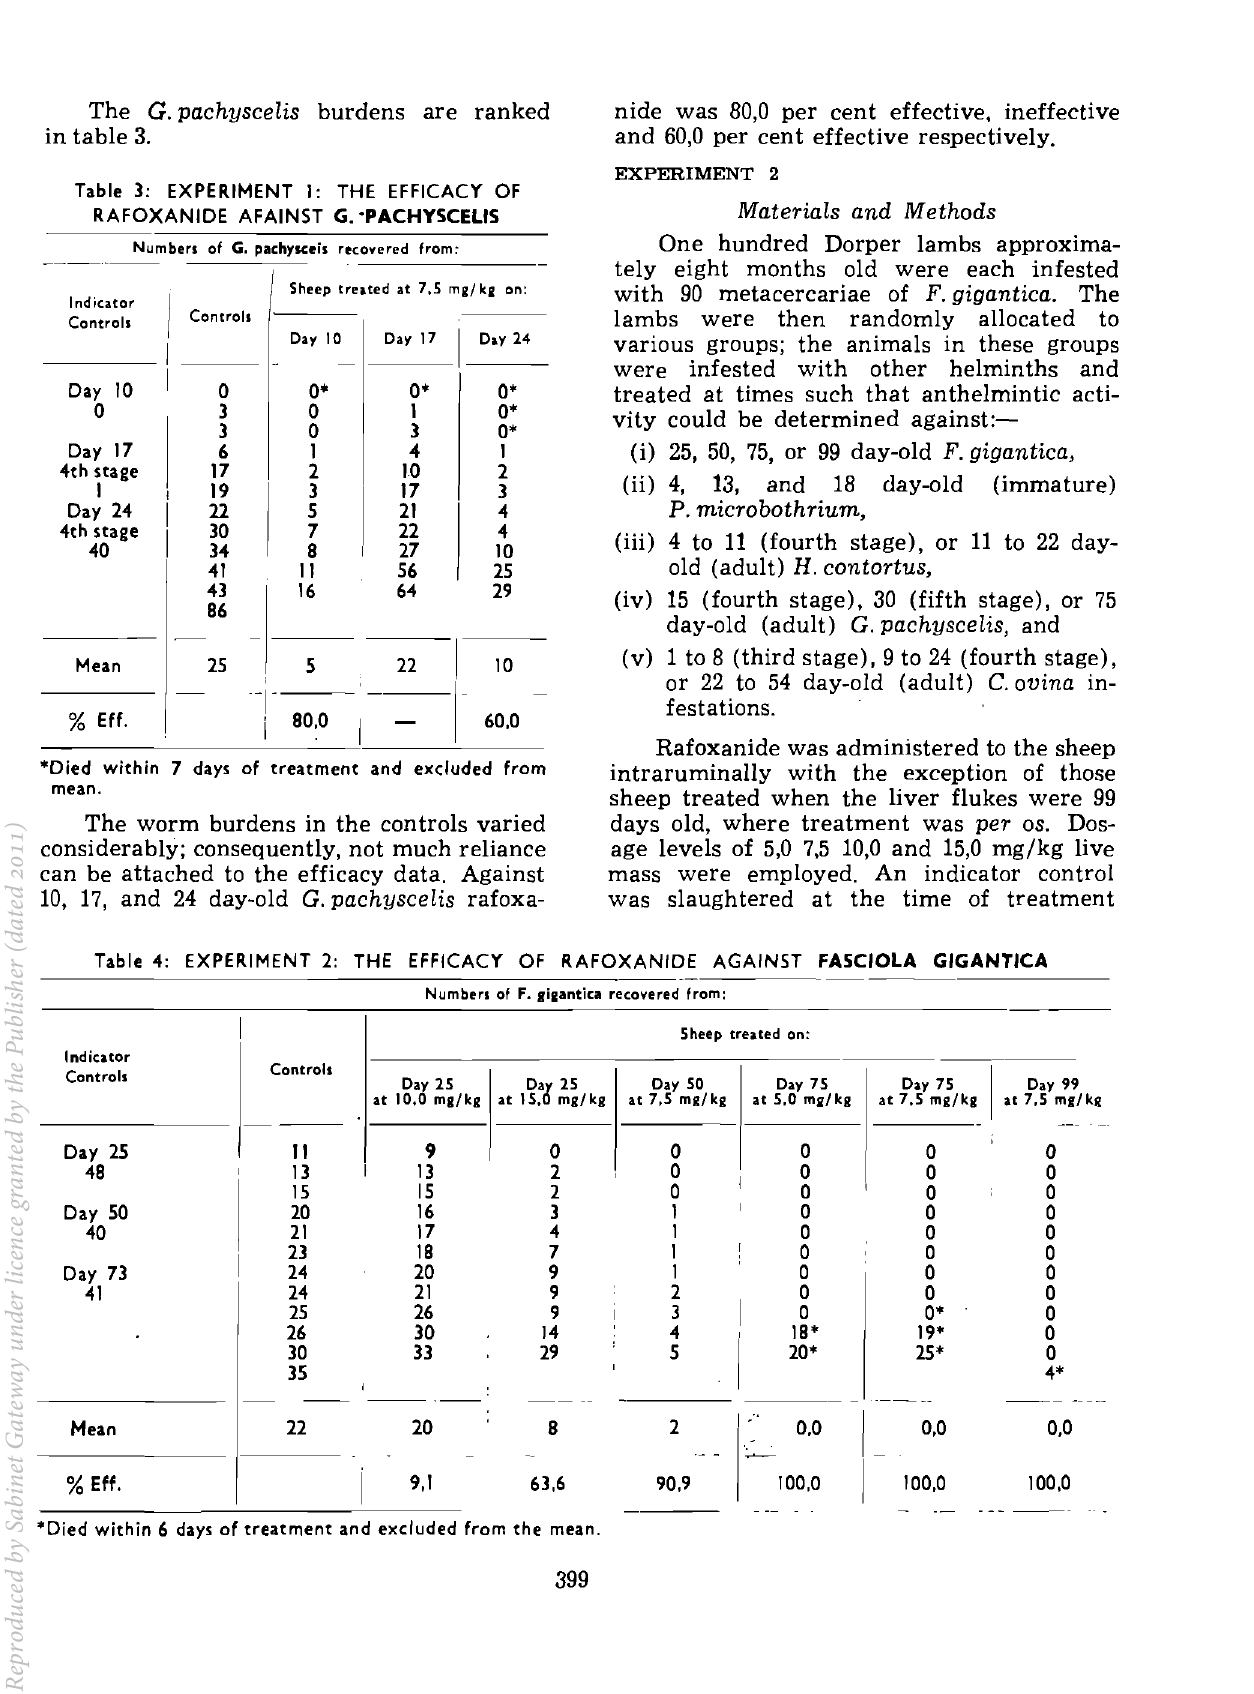
Table 4: EXPERIMENT 2: THE EFFICACY OF RAFOXANIOE AGAINST FASCIOLA GIGANTICA Numbers of F. Illantlca recovered from: Indicator